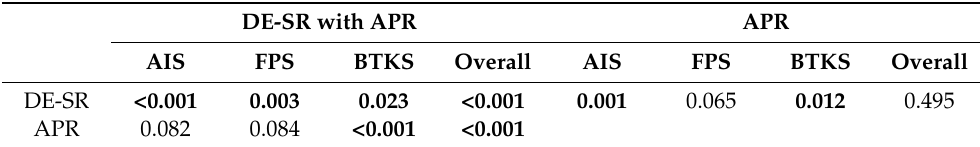
Table 4. p -Values for the pairwise comparison of accuracies in detection of significant stenosis (according to segment) presented in Table